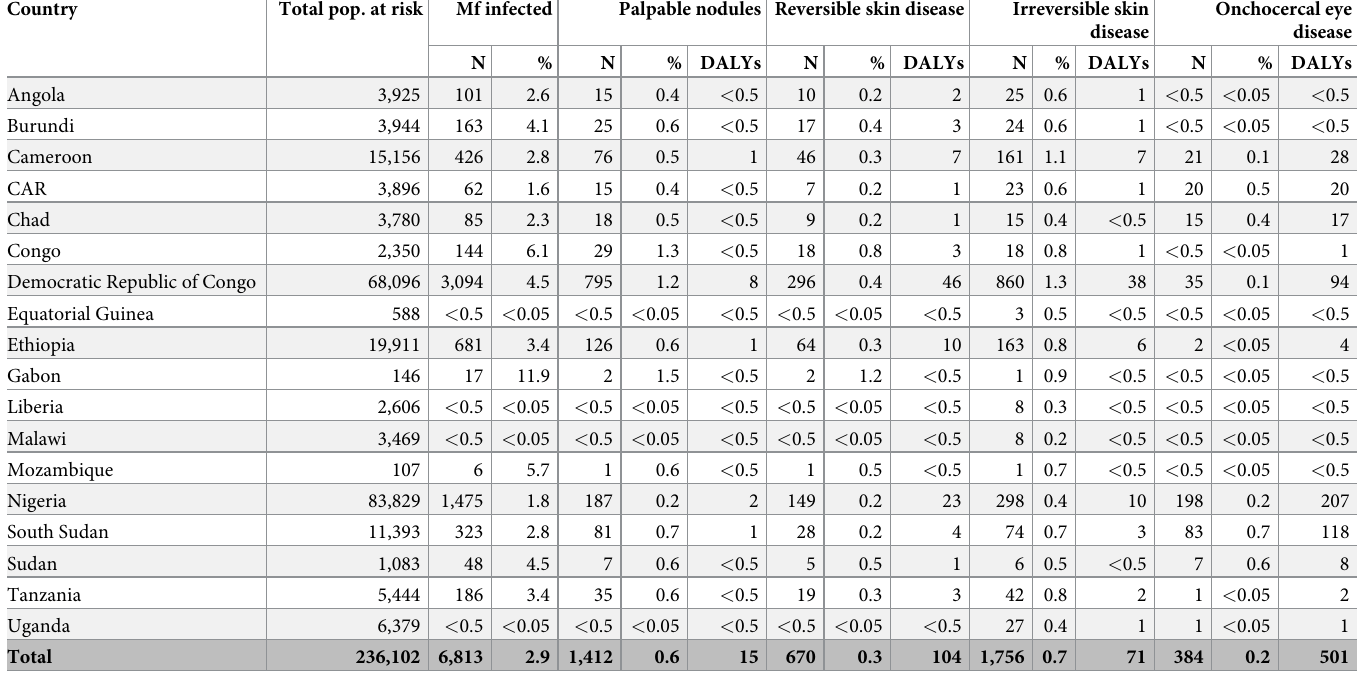
Table 3. Population at risk and numbers of cases infected and with clinical manifestations by country for 2030. Absolute numbers (N and DALYs) are presented in thousands. Country Total pop. at risk